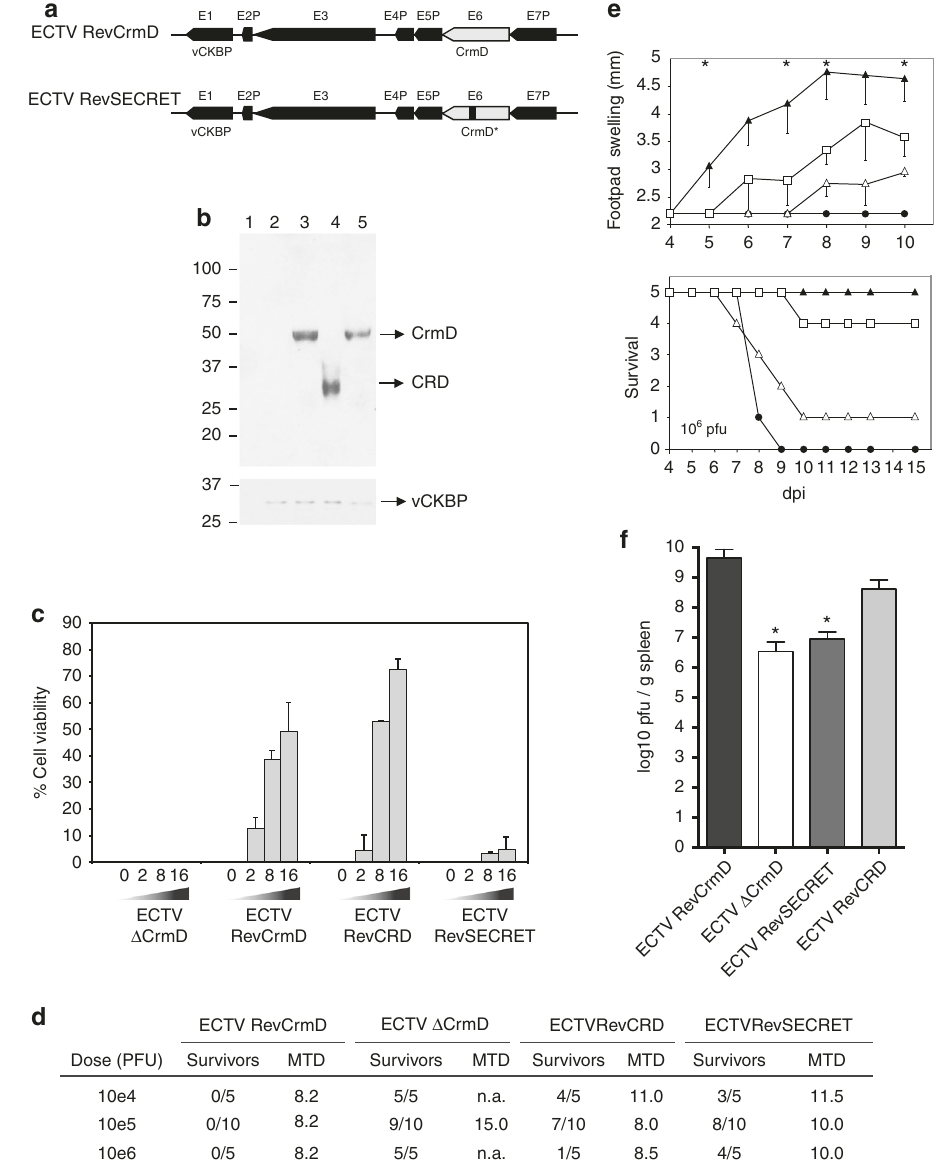
Fig. 7 The activity of the SECRET domain in vivo is dependent on concomitant TNF blockade. a Schematic diagram of the genomic structure of ECTV RevSECRET. The genes fl anking the CrmD locus are indicated. In gray, the CrmD locus in the parental and recombinant virus is shown. Presence of a point mutation (N77F) in the CrmD of ECTVRevSECRET is indicated by an asterisk and a black line. Only the left inverted terminal repeat is shown. b Western blot analyses using anti-CrmD and anti-35-kDa vCKBP antisera of supernatants from BSC-1 cells mock-infected (1) or infected with ECTV Δ CrmD (2), ECTVRevCrmD (3), ECTVRevCRD (4) or ECTVRevSECRET (5) at a multiplicity of infection of 5 PFU/cell and harvested at 24 h post-infection. The position of the proteins is indicated by arrows. Molecular size markers in kDa are shown on the left. c TNF-induced cytotoxicity assay. Increasing amounts of supernatants (equivalent to 2, 8 or 16 × 10 3 cells) from cells infected with the indicated viruses were added to block the effect of TNF on L929 cells. Values of % cell viability obtained in the presence of mock-infected cell supernatants were subtracted from the % cell viability caused by the corresponding supernatant volume from virus-infected cells. Data are mean + / − SD of triplicate samples. d Mortality rate determination of CrmD recombinant ECTVs in susceptible mice. Groups of fi ve or ten female BALB/c mice were infected s.c. in the left hind footpad with different doses of the indicated viruses. The number of survivors at 15 dpi and the mean time to death (MTD) in days for each condition are shown. n.a., not applicable. e Groups of fi ve female BALB/c mice were inoculated s.c. in the left hind footpad with 10 6 PFU of ECTV RevCrmD (black circles), ECTV Δ CrmD (black triangles), ECTVRevCRD (white triangles) or ECTVRevSECRET (white squares) and monitored daily for mortality and footpad swelling, as indicated. Data are shown as mean + / − SD. Asterisks indicate time points at which signi fi cant differences ( p < 0.01, multiple t tests with false discovery rate correction at Q = 1%) between ECTV Δ CrmD and ECTVRevSECRET-inoculated mice were found. f Replication of recombinant ECTVs in spleen. Viral titres at 7 dpi in spleen of mice infected with 10 5 PFU per animal of the indicated viruses. Data are mean log + / − SD of groups of fi ve mice for each condition. Groups signi fi cantly different from the ECTVRevCrmD-infected group are indicated (asterisks p < 0.05, ANOVA with Bonferroni multiple comparison